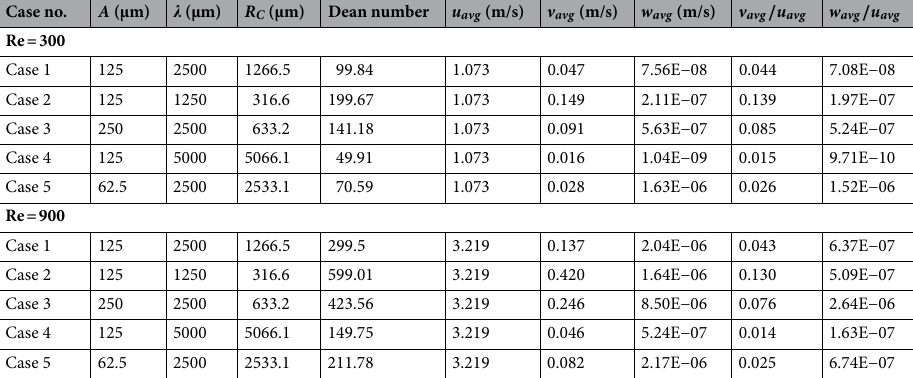
Table 5. Velocity components and ratios for wavy cases in average velocity